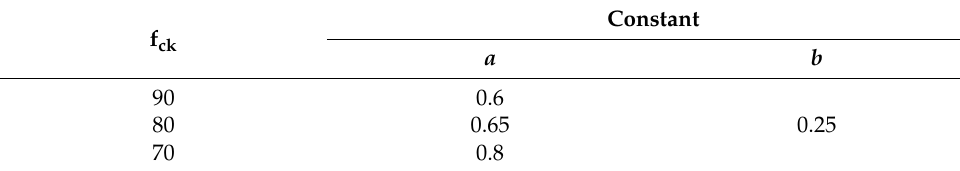
Table 5. Experimental constants a , b in Equation (7,8).